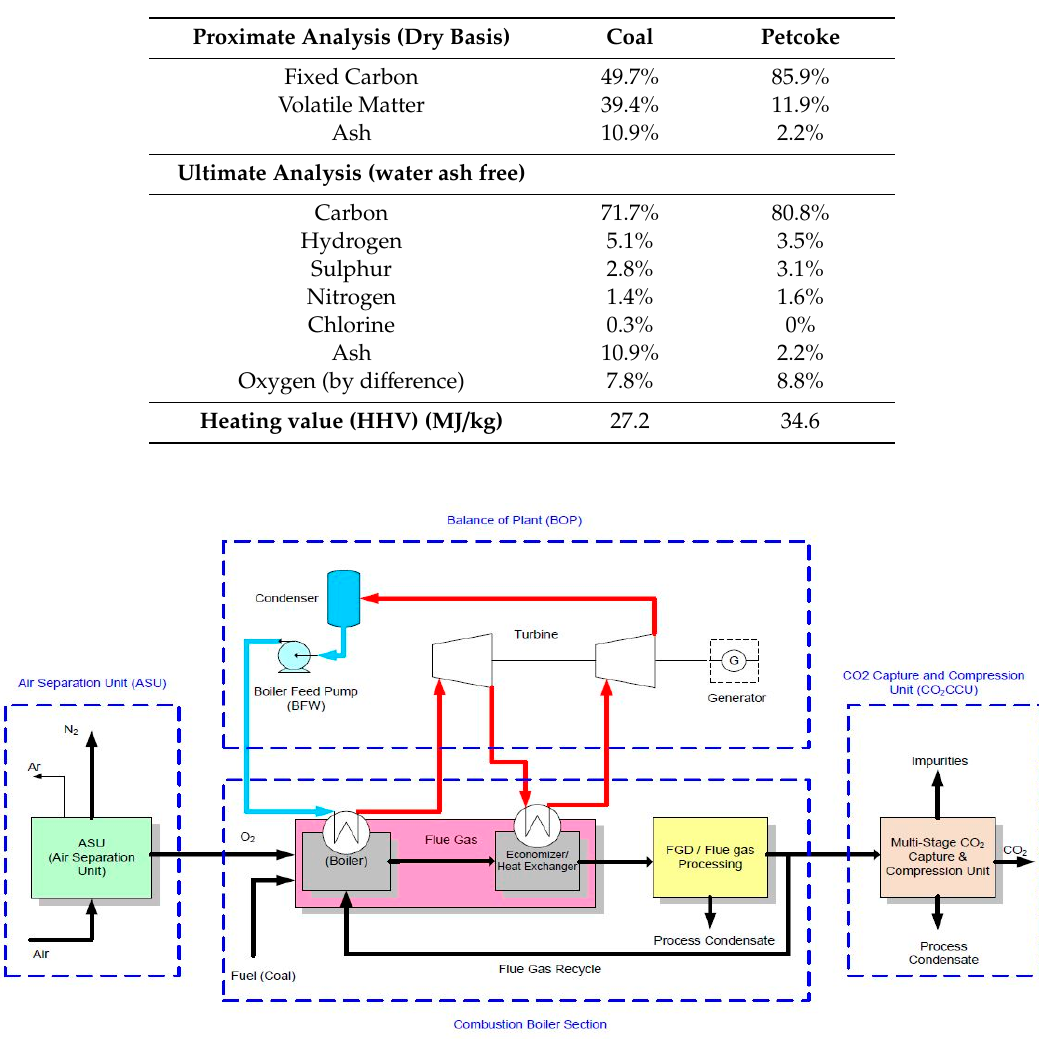
Figure 1. Typical oxy-fuel power plant [15].